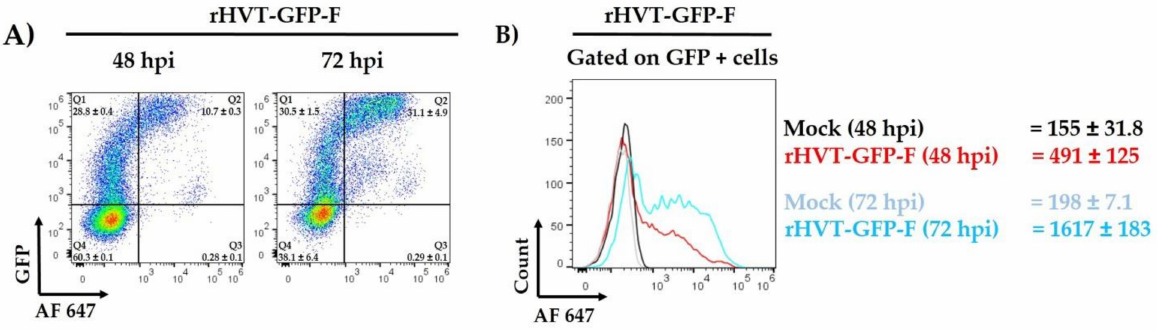
Figure 2. Evaluation of the cell surface expression of the F protein and its expression over time. The cells were infected with the rHVT-GFP-F virus at a multiplicity of infection (MOI) of 0.01 and harvested at 48 and 72 h post-infection (hpi) to evaluate the cell surface expression and overall expression levels of the F protein. The CEF cells were labeled with anti-NDV chicken serum as the primary antibody and Alexa Fluor ® 647-labeled anti-chicken IgY as a secondary antibody. ( A ) Percentage of infected cells